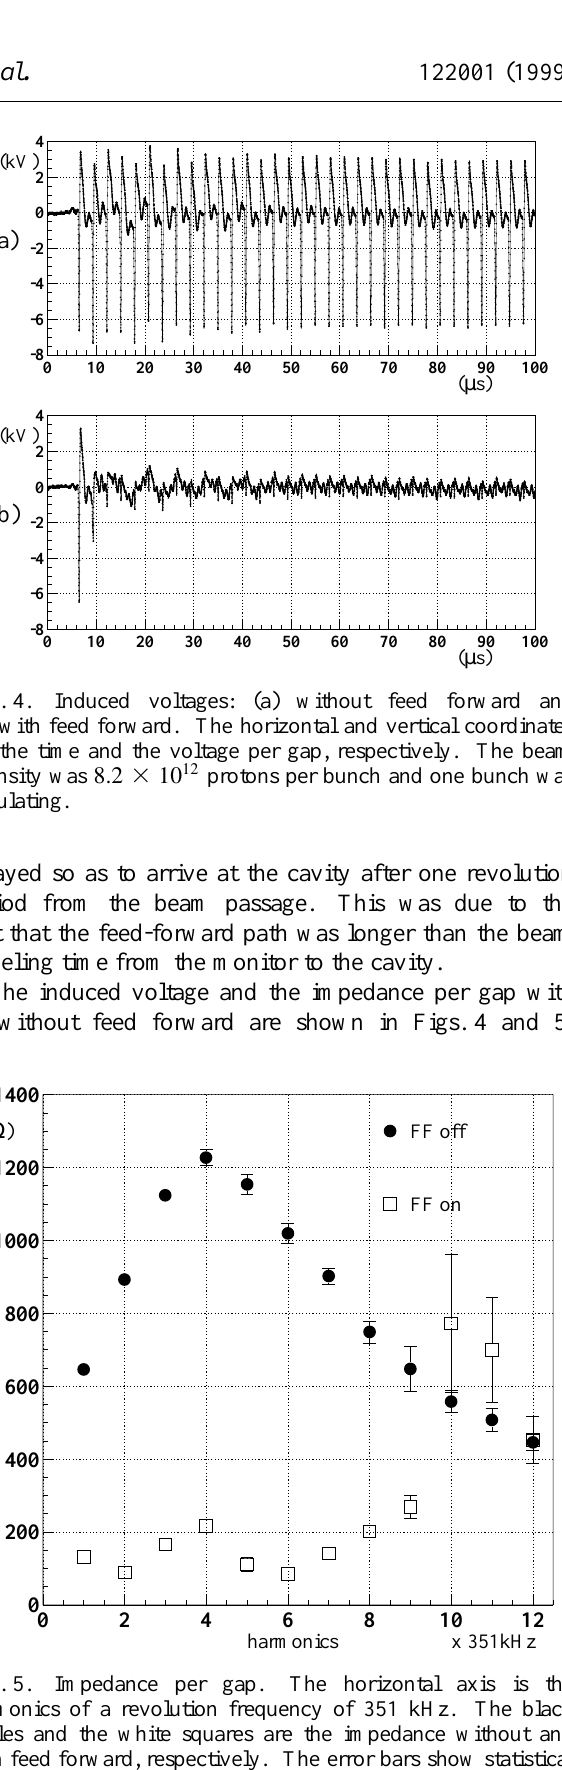
FIG. 3. Schematic view of the feed-forward system.